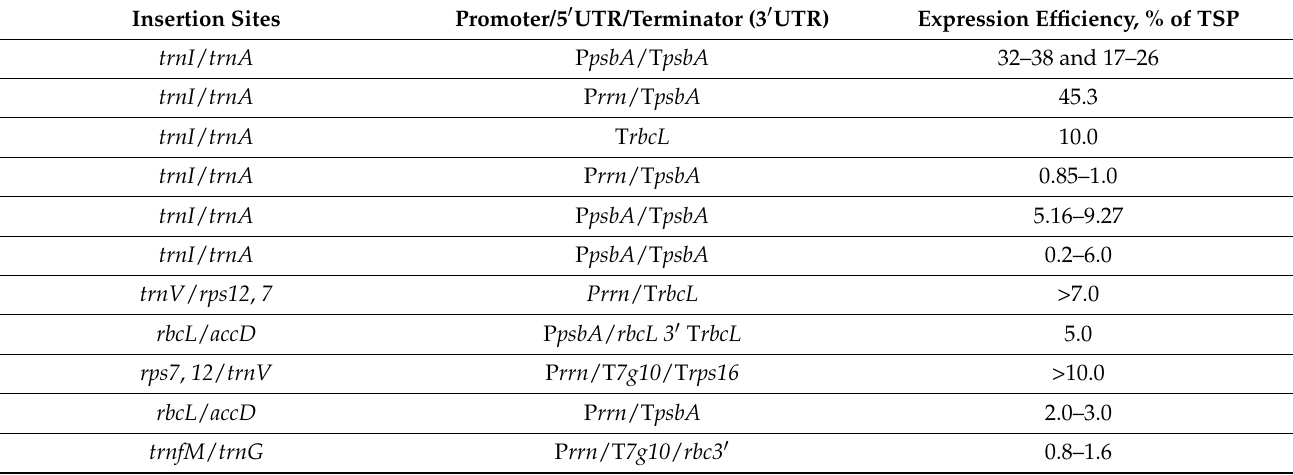
Table 4. Variation of expression of several recombinant proteins depending on the insertion site, promoters, and regulatory regions (according to [184] with some